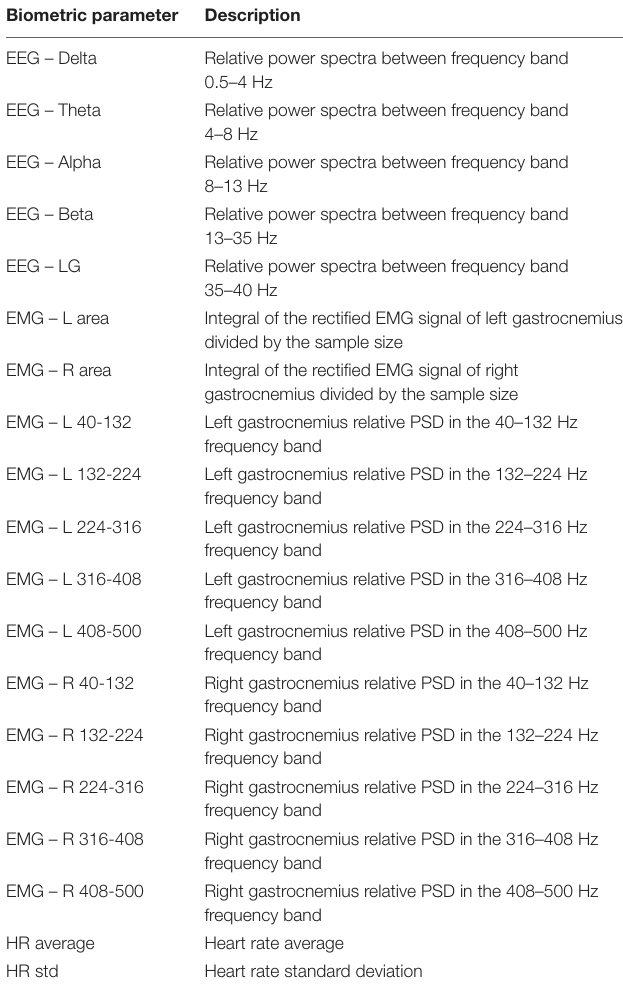
TABLE 1 | Description of the 19 biometric parameters that compose the database. Biometric